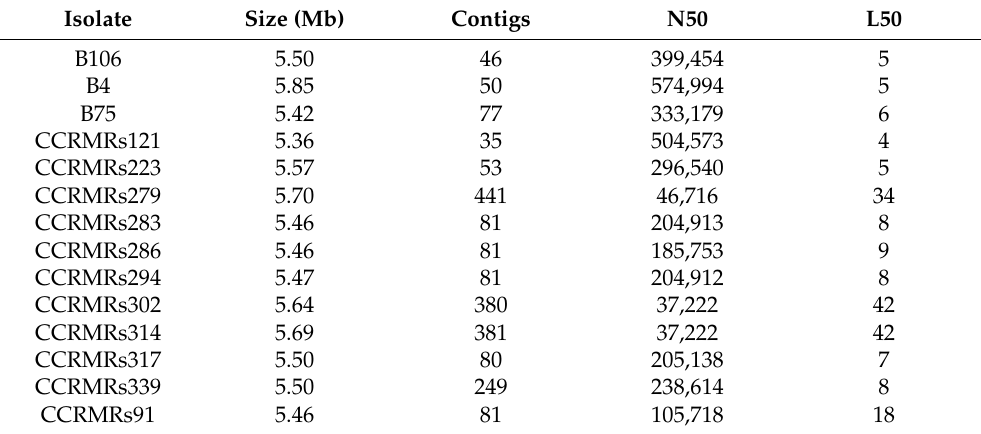
Table 1. Quality metrics for Northern and Northeastern sequenced RSSC isolates. Isolate Size (Mb) Contigs N50